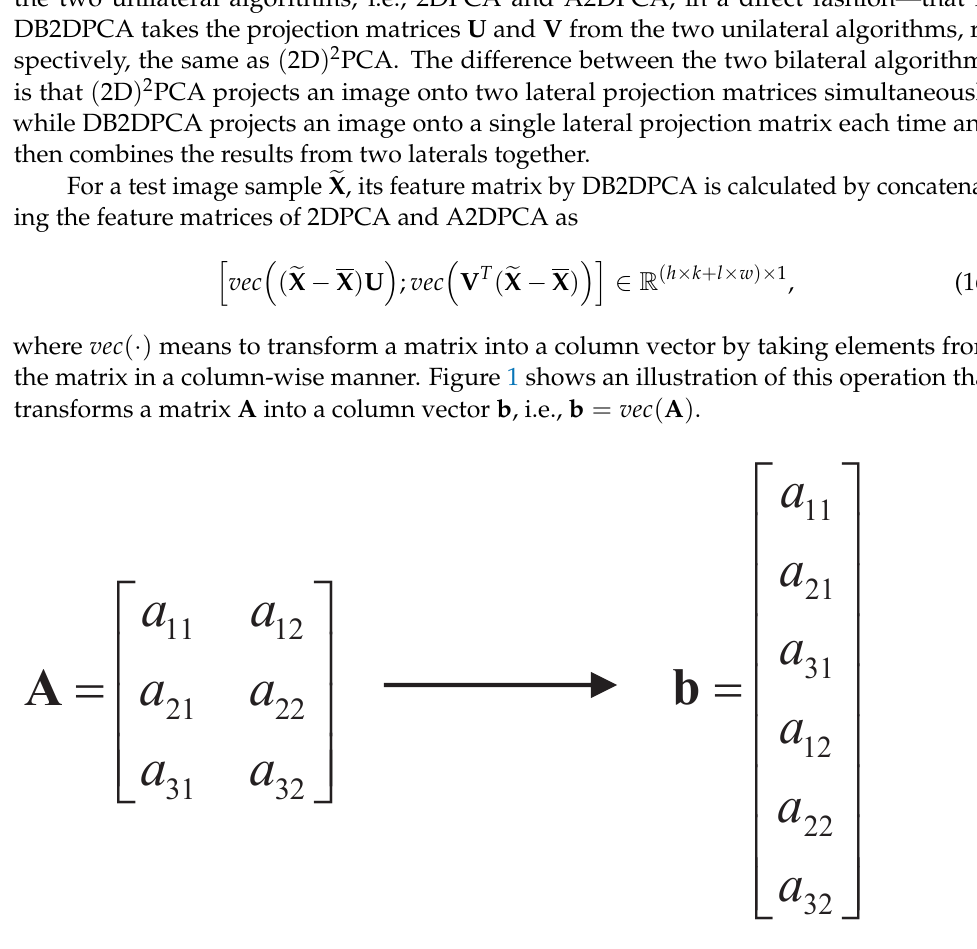
Figure 1. An illustration of transforming a matrix into a column vector by taking elements from the matrix in a column-wise